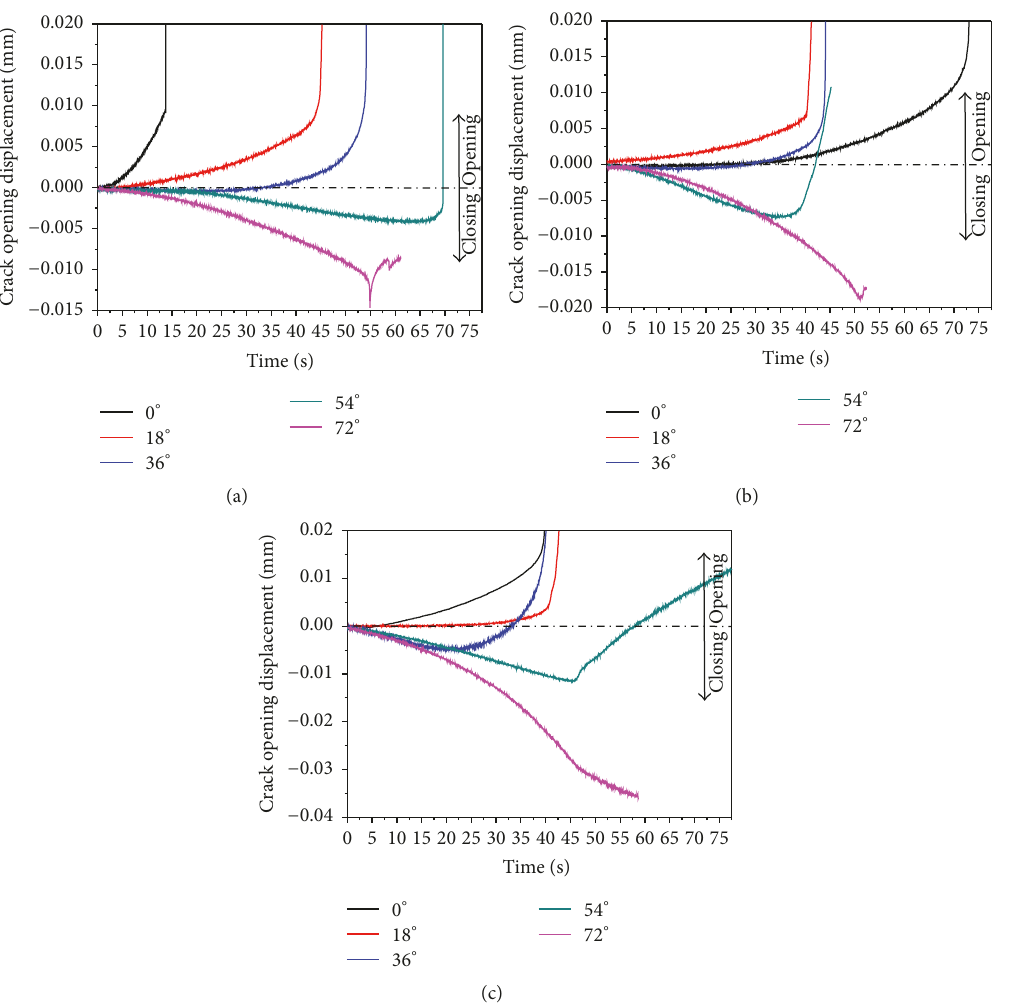
Figure 8: Crack opening displacement for specimens: (a) 2𝑎 = 15 mm; (b) 2𝑎 = 20 mm; (c) 2𝑎 = 25 mm.